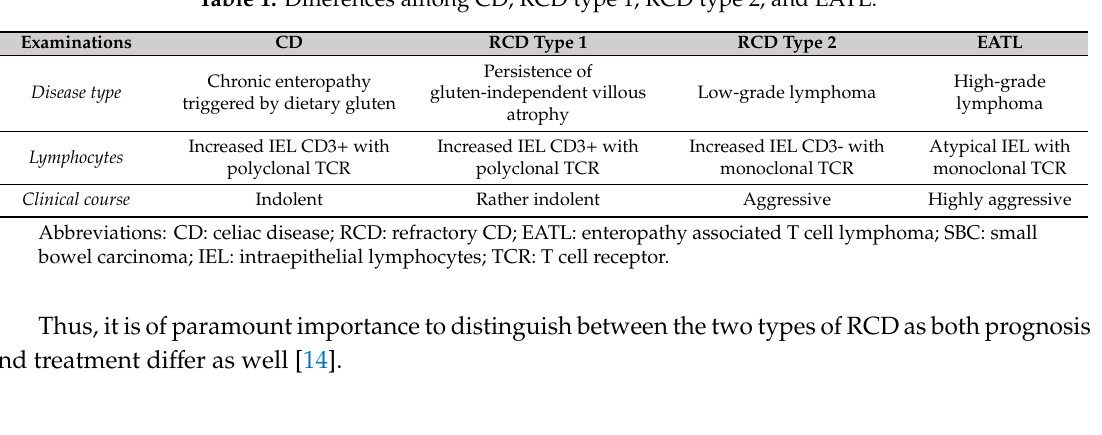
Table 1. Di ff erences among CD, RCD type 1, RCD type 2, and